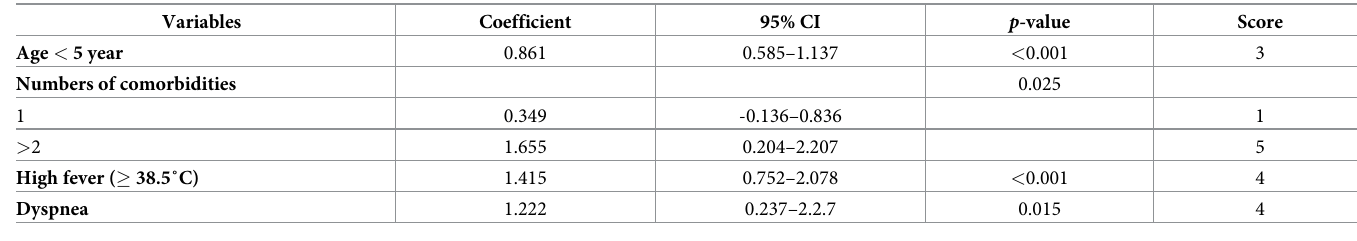
Table 3. Clinical predictive score for pneumonia.